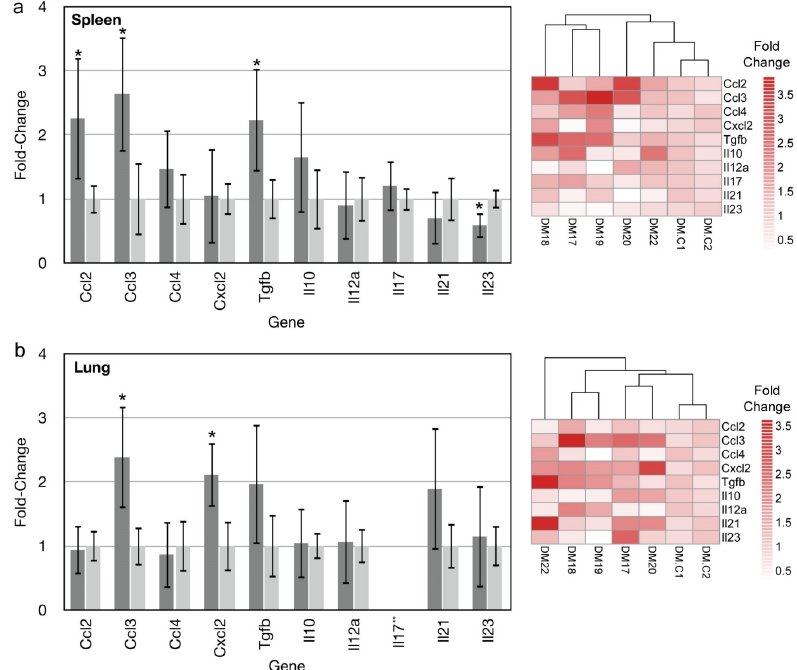
Figure 3. Cytokine and chemokine gene expression in spleens and lungs of MAPV ‐ infected deer mice. Fourteen days post infection, spleens and lungs of 5 deer mice were examined for the expression of 10 genes by real ‐ time PCR. Ccl2 , Ccl3 and Tgfb were elevated in spleens of infected deer mice (dark gray) compared to uninfected deer mice (light gray), whereas Il23 expression was repressed. Error bars represent 95% confidence intervals and those denoted by * are statistically different from the uninfected control. Heat map indicates fold ‐ change of individual deer mice used in generating the graph of infected deer mice (DM17–DM22) and uninfected controls (DM.C1, DM.C2) ( a ). In lungs, only Ccl3 and Cxcl2 were elevated. Heat map indicates fold ‐ change of individual deer mice used in generating the graph of infected deer mice (DM17–DM22) and uninfected controls (DM.C1, DM.C2). ** Il17 was not detected in either infected or uninfected lung samples ( b ).